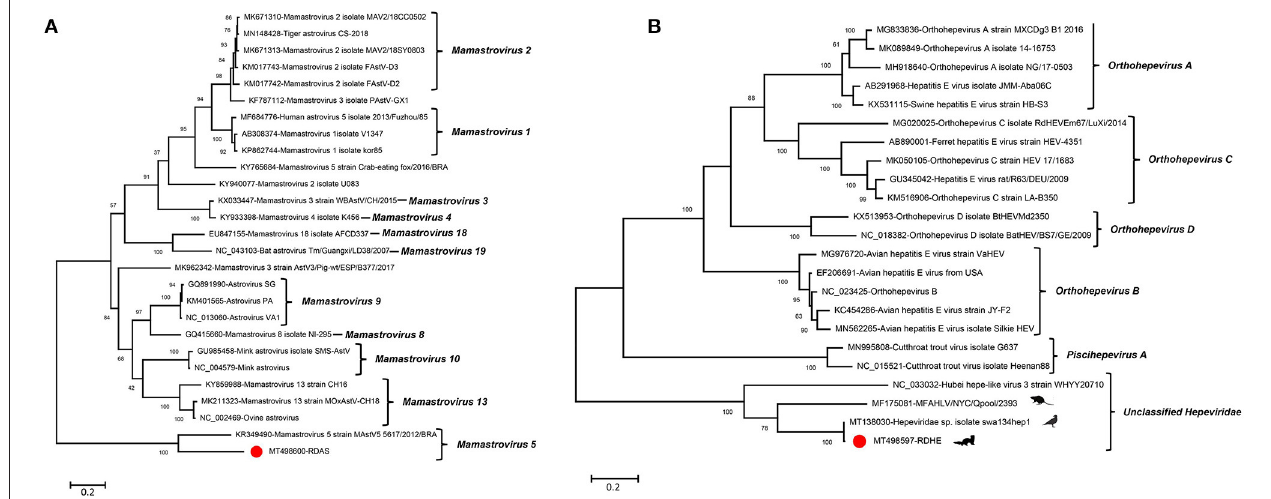
FIGURE 6 | Phylogenetic analysis of an astrovirus and a hepe-like virus identified in this study. (A) For astrovirus (RDAS). (B) For hepe-like virus (RDHE). The two viruses identified in this study were marked with a red solid